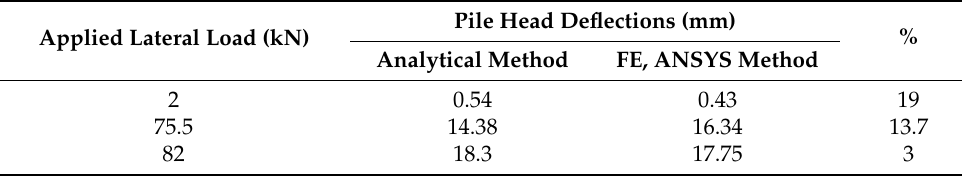
Figure 4. The lateral deflection profiles of piles for different lateral loads ( a ) 2 kN, ( b ) 75.5 kN, and ( c ) 80 kN applied at a distance of 1 m above ground surface. Table 3. Pile head deflections obtained from the analytical and FE methods.